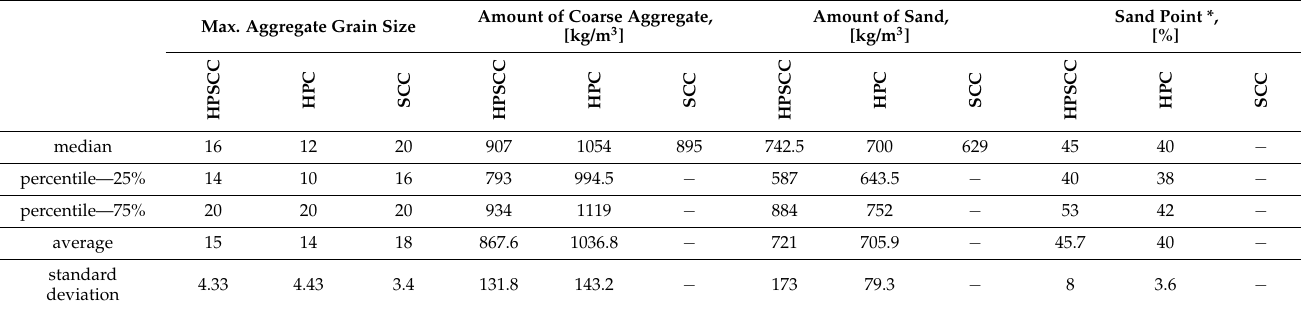
Table 3. Statistics compilation for SCC, HPC and HPSCC aggregate.